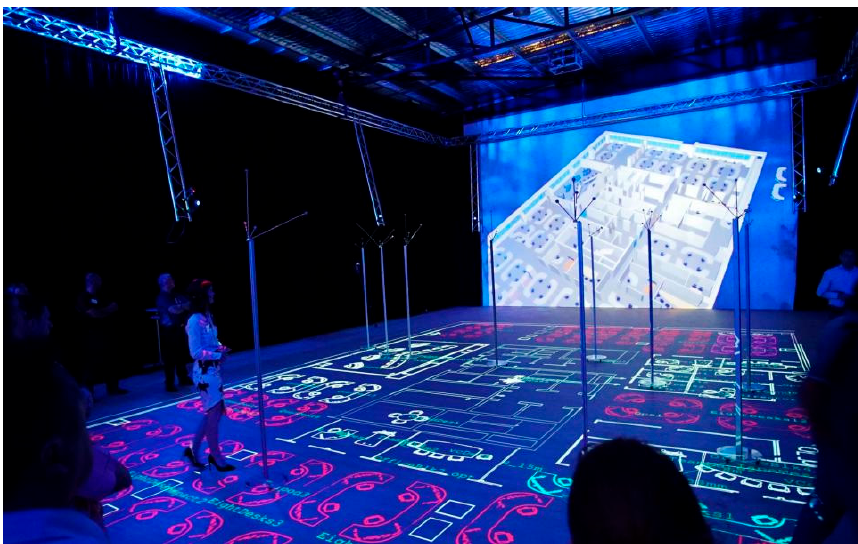
Figure 1. CADwalk installation showing projected building blueprints and rendered view on rear wall (head-mounted-display (HMD) view not shown).